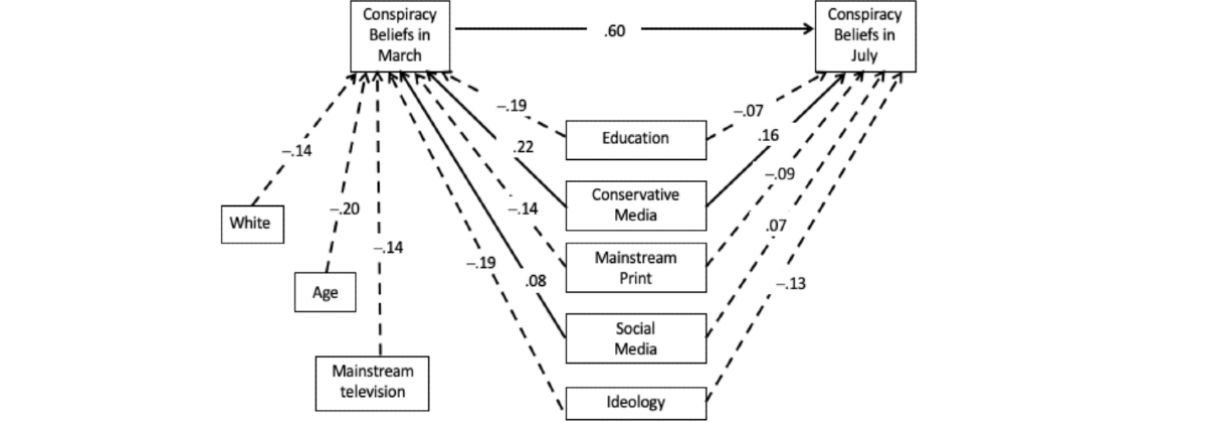
Figure 1. Standardized predictors of conspiracy beliefs in March and again in July with all coefficients falling within 99% CIs, except for social media and conspiracy beliefs in